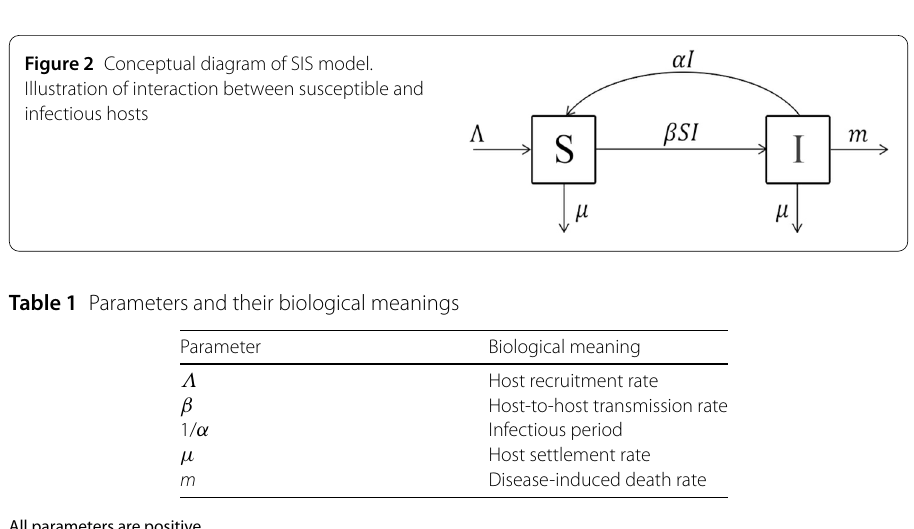
Figure 2 Conceptual diagram of SIS model. Illustration of interaction between susceptible and infectious hosts